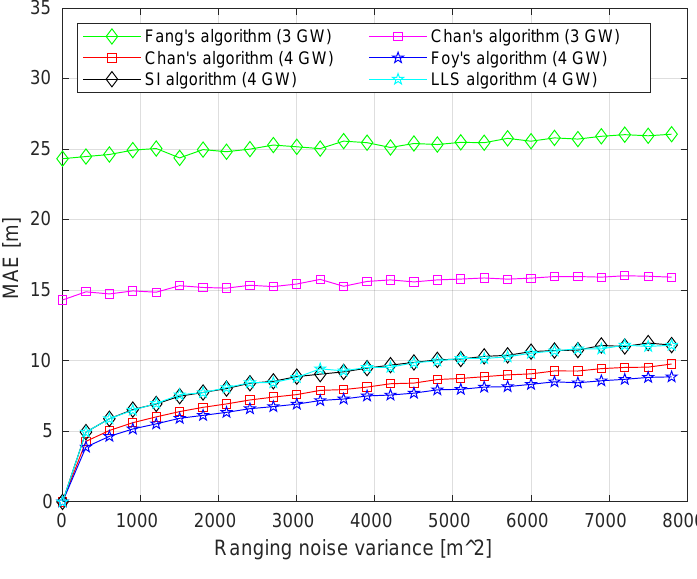
Figure 7. Ranging noise vs. mean absolute error (MAE) for selected TDoA